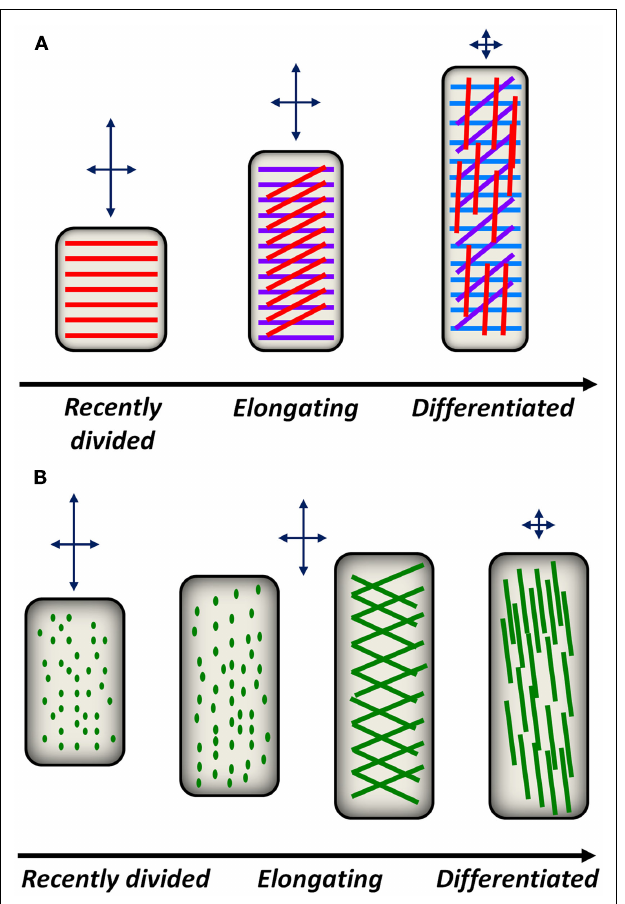
FIGURE 2 | Conceptual models for cell wall polysaccharide deposition and reorientation during plant development. (A) A model for cellulose deposition and reorientation in anisotropically elongating root epidermal cells. Shortly after division in the root meristematic region, cellulose synthase complexes in epidermal cells deposit cellulose (red lines) in a transverse orientation with respect to the elongation axis.This deposition pattern constrains radial expansion of the cell but permits axial expansion as indicated by the arrows above each cell. As epidermal cells elongate, new cellulose layers (magenta lines, blue lines) are deposited transversely, while older layers in the apoplast passively reorient from transverse to diagonal, then longitudinal orientations.The reorientation of older cellulose layers reduces the ability of differentiating cells to expand in the axial direction. (B) A model for pectin deposition and remodeling in the apoplast. In recently divided cells, pectic polysaccharides are delivered to the apoplast by secretory vesicles. Putative sites of pectin delivery (green dots) can be imaged with FucAl and are initially distributed evenly across the cell. As epidermal cells stop elongating, diagonal fibrils begin to appear that eventually reorient toward the longitudinal axis, potentially constraining further axial